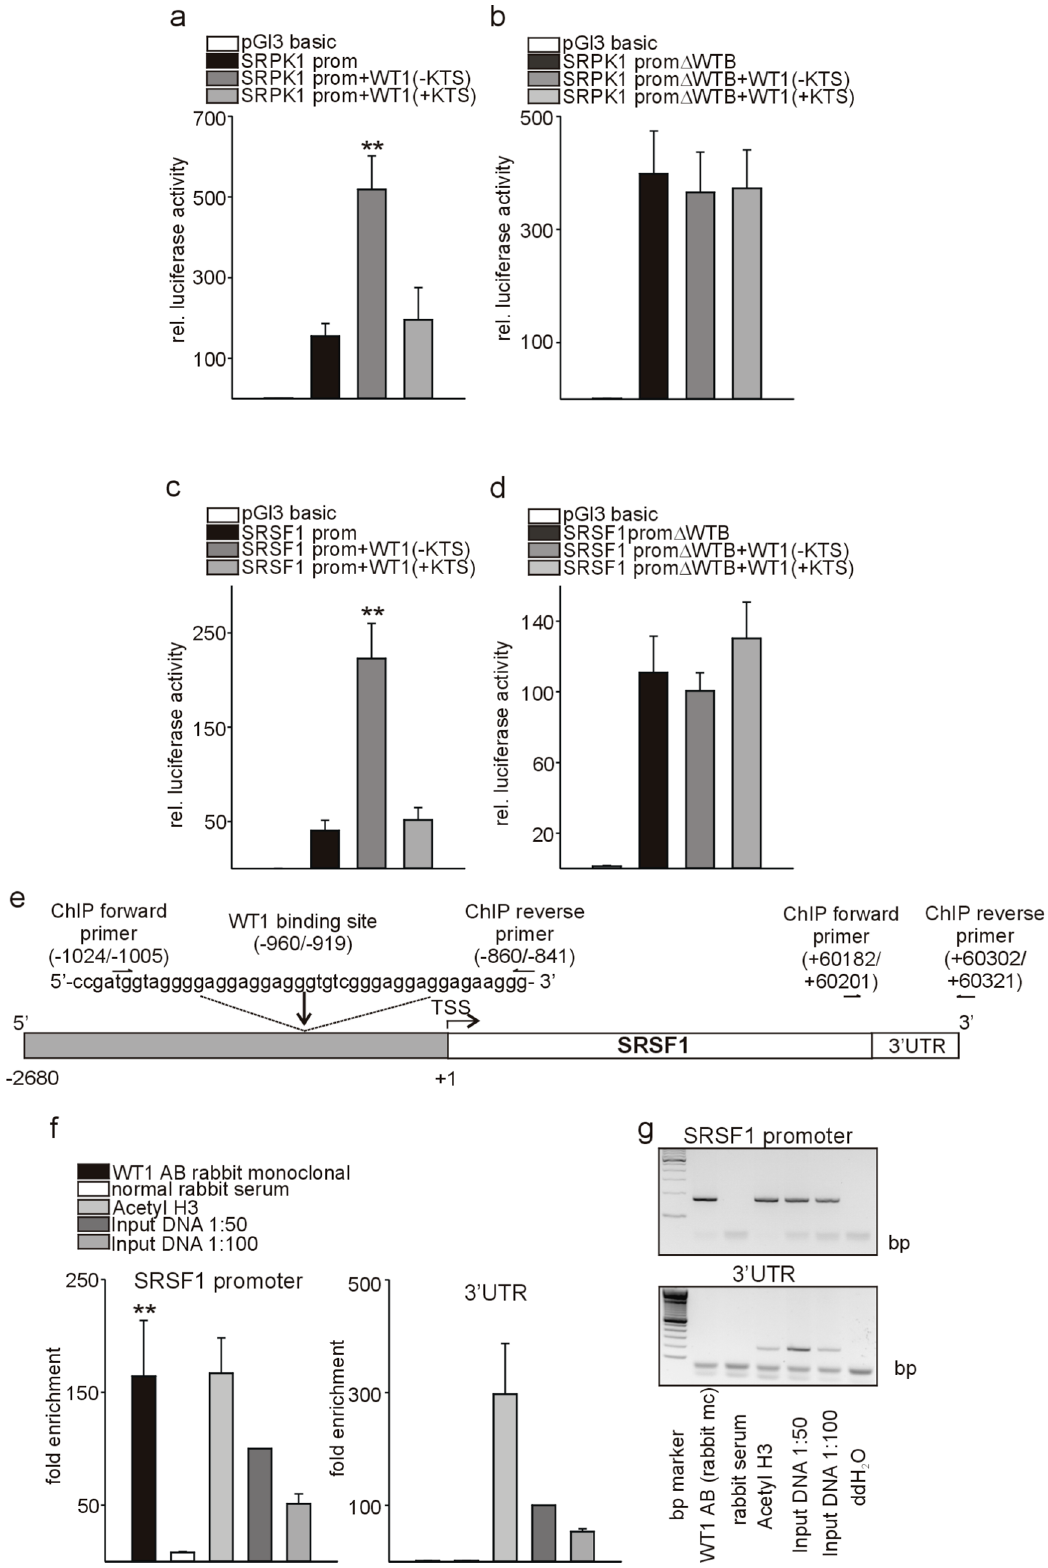
Figure 6. WT1 activates SRPK1 and SRSF1 in endothelial cells. ( a ) Relative luciferase activity of a reporter construct carrying the SRPK1 promoter [19] in the presence of WT1( − KTS) or WT1(+KTS) expression constructs. Transient transfections were performed using C166 cells ( n = 12 each). The promoterless luciferase expression construct (pGl3basic) served as a negative control. Co-transfected beta-Galactosidase was used to normalize for differences in transfection efficiencies. ( b ) Relative luciferase activity of a SRPK1 promoter reporter construct with deletion of the identified